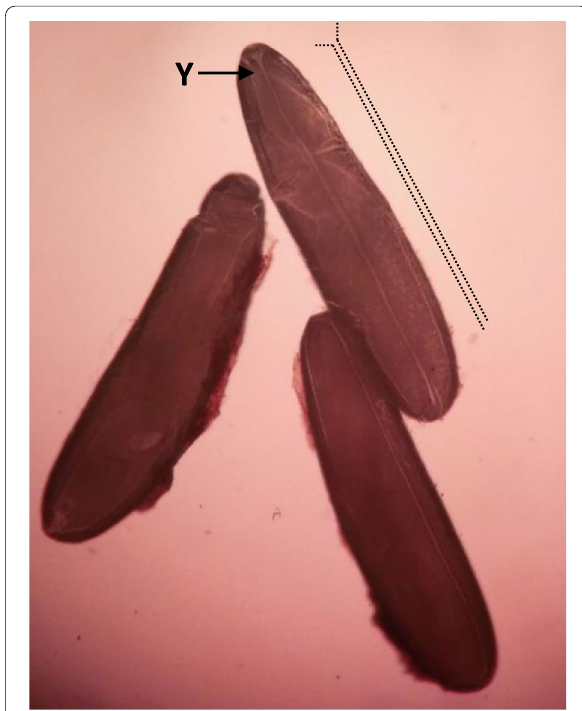
Fig. 5 Microscopic features of Chrysomya megacephala eggs found on the hair of a corpse ( 400 magnification). Y—‘Y’-shaped and × narrow plastron of the Chrysomya megacephala